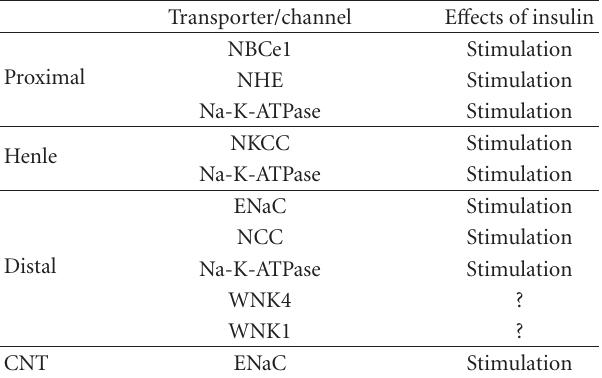
Table 1: E ff ects of insulin on renal transporters, channels, or